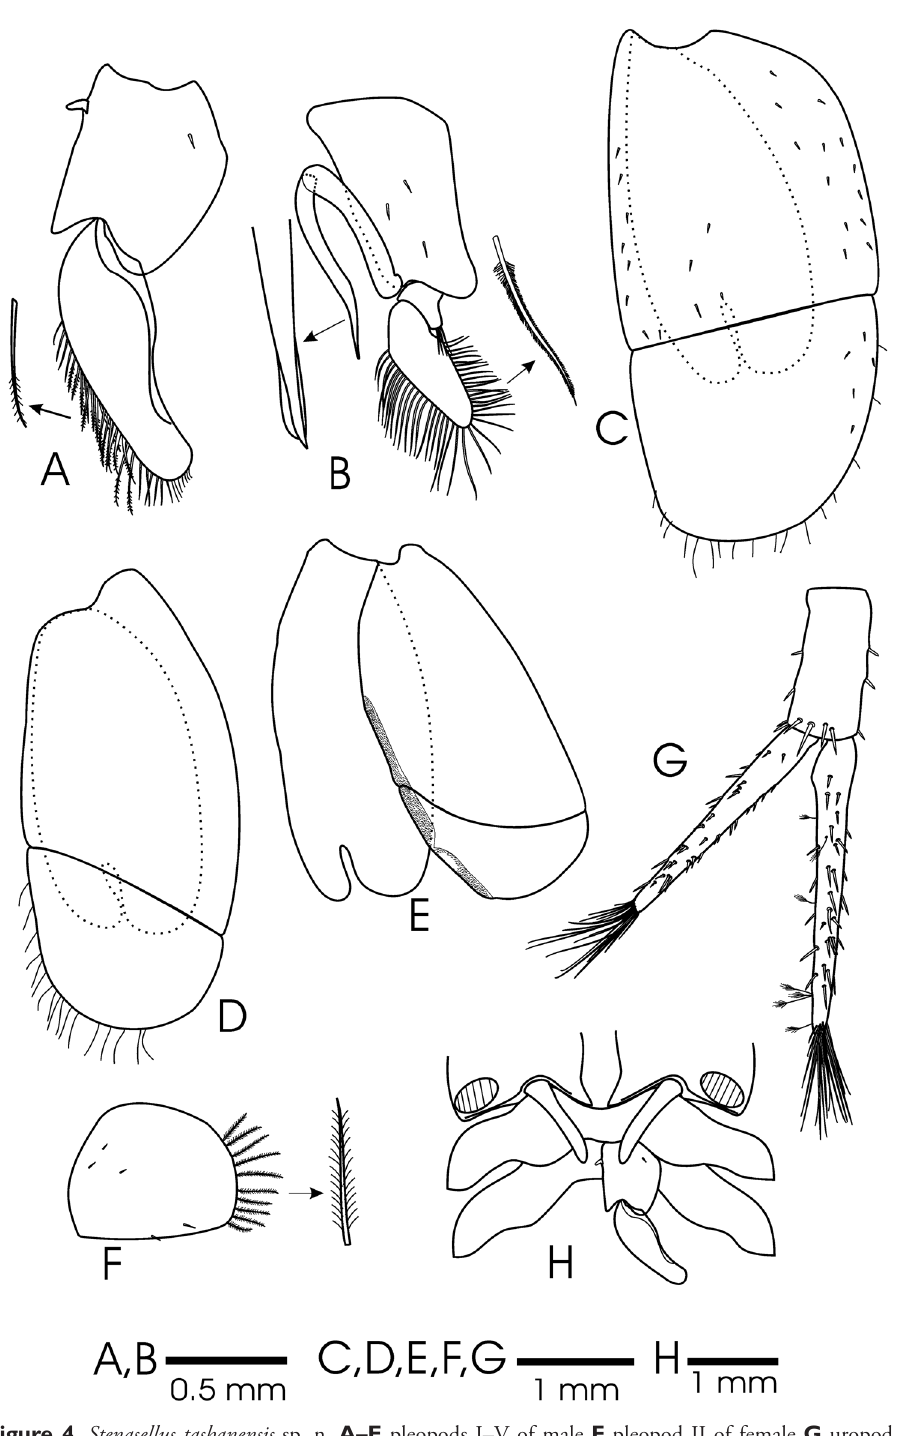
Figure 4. Stenasellus tashanensis sp. n. A–E pleopods I–V of male F pleopod II of female G uropod H genital papillae on seventh